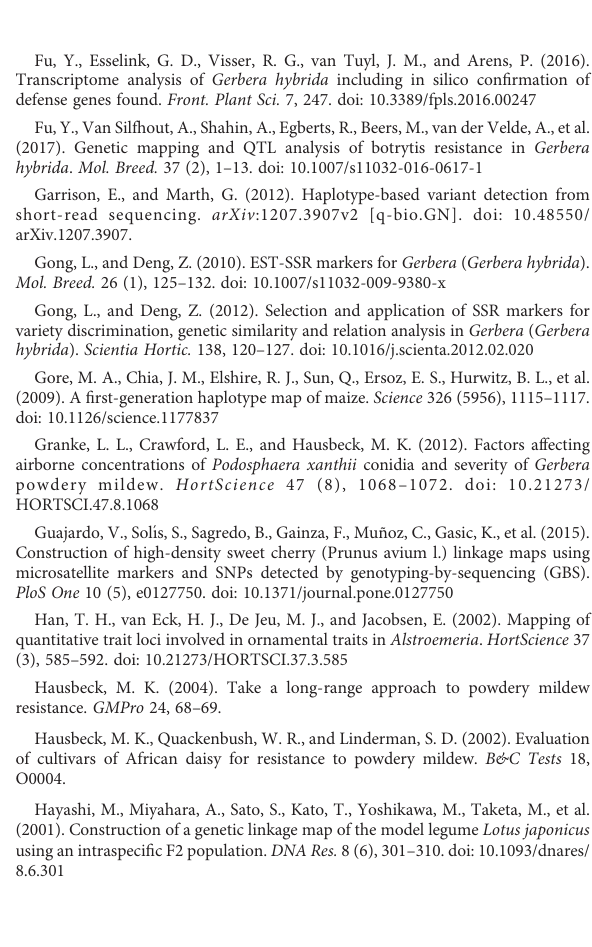
SUPPLEMENTARY FIGURE 1 Histogram of one high-resolution melting (HMR) curve marker developed from one of the SNPs that is linked to the major QTL GhPMR1 . Two patterns, indicated by the red and blue melting curves, were evident among the Gerbera parental and F 1 individuals. This marker could clearly differentiate Gerbera individuals, but as the QTL GhPMR1 explained only 16.6% or 20.4% of the phenotypic variance for PM resistance, this marker had only a limited diagnostic capability for PM resistance. Additional QTLs and SNP markers are needed for reliable selection of PM-resistant Gerbera breeding